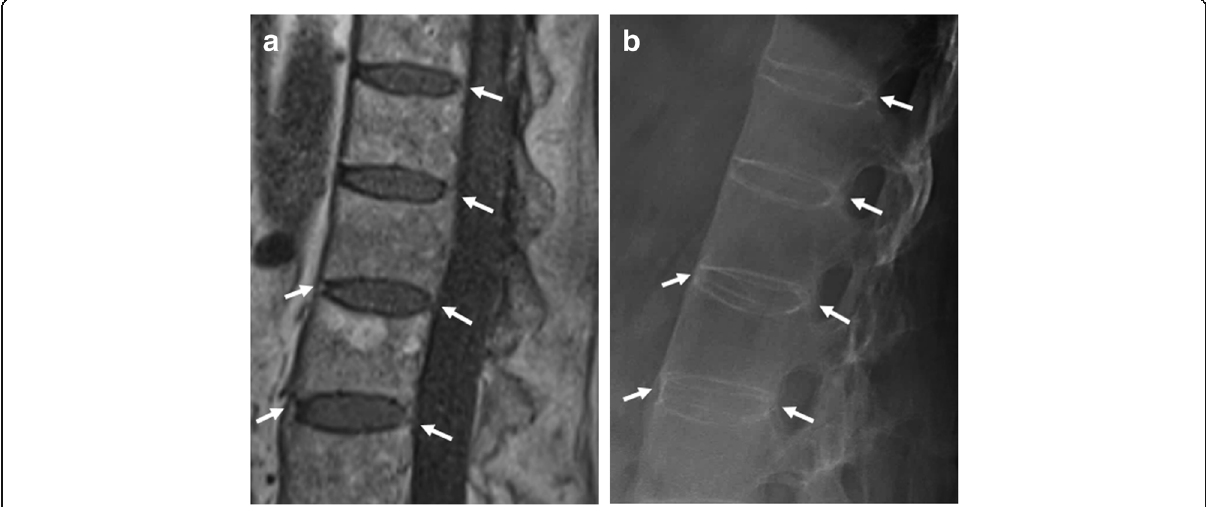
Fig. 7 Vertebral corner bridging. a Sagittal T1-weighted MR imaging acquired in a 57-year-old man with SpA shows bridging syndesmophytes (arrows), and ( b ) radiography of the same vertebrae confirms these vertebral corner bridges (arrows) resulting in a “ bamboo spine ”